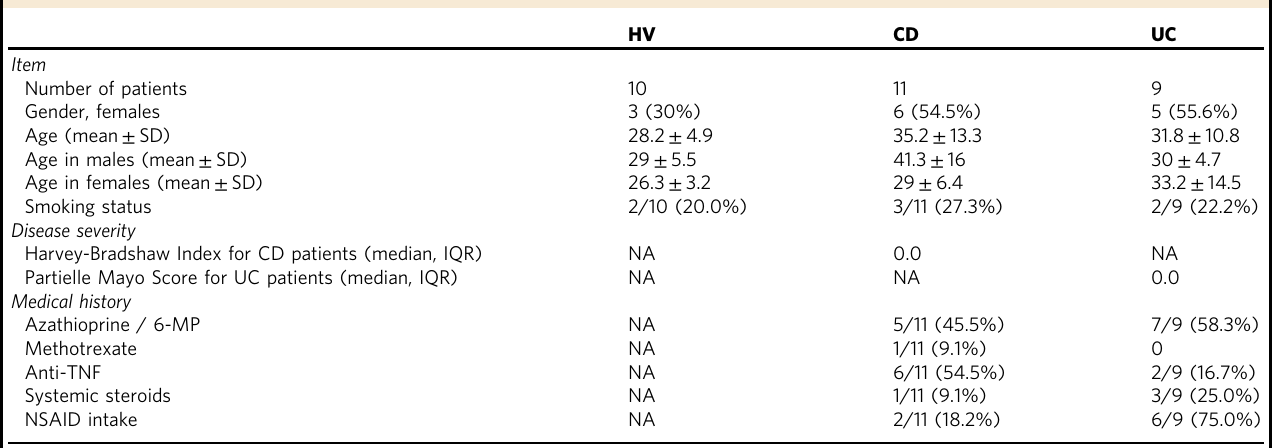
Table 1 Participant